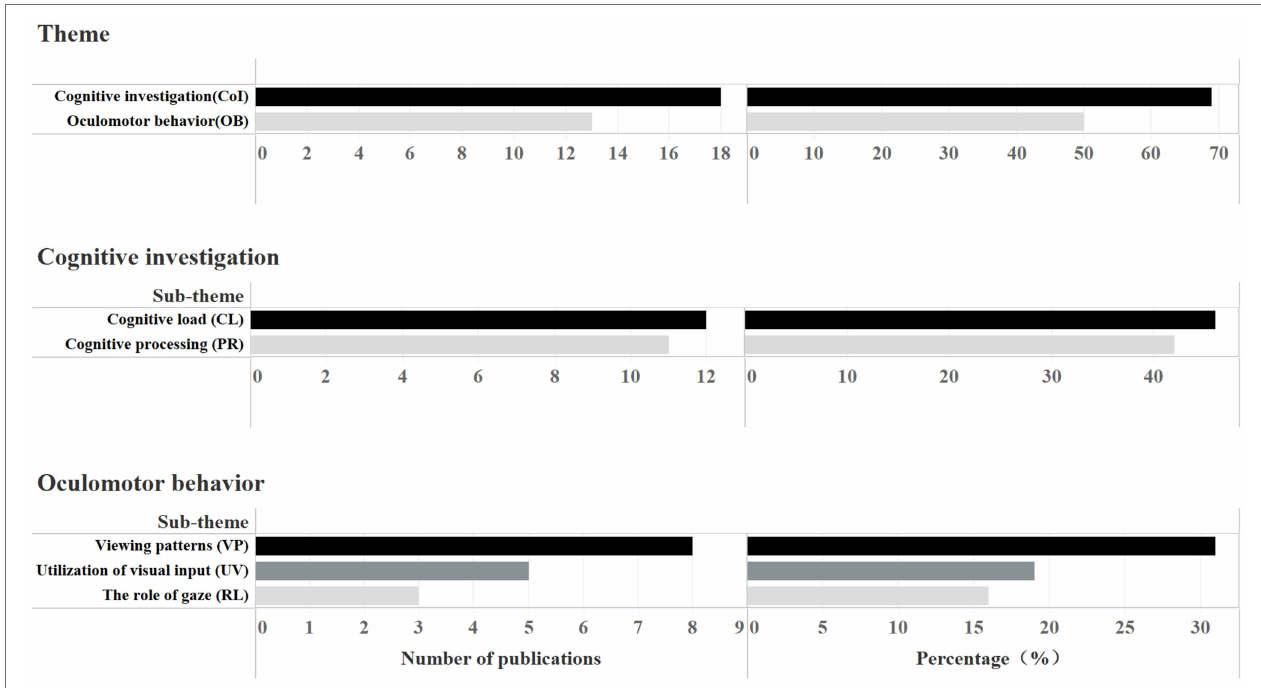
FIGURE 5 | Number and proportion of papers investigating each theme and their